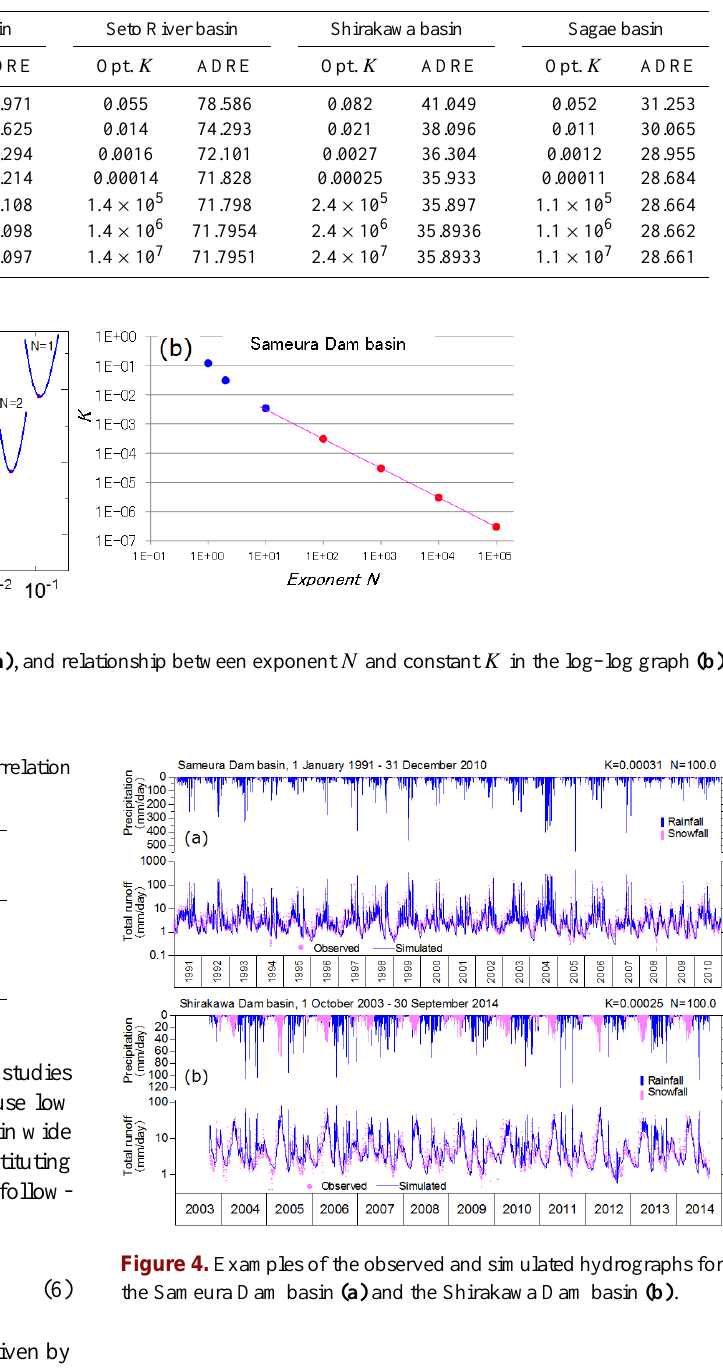
Table 2. Analysis conditions and simulated optimum values of K and ADRE for each basin.